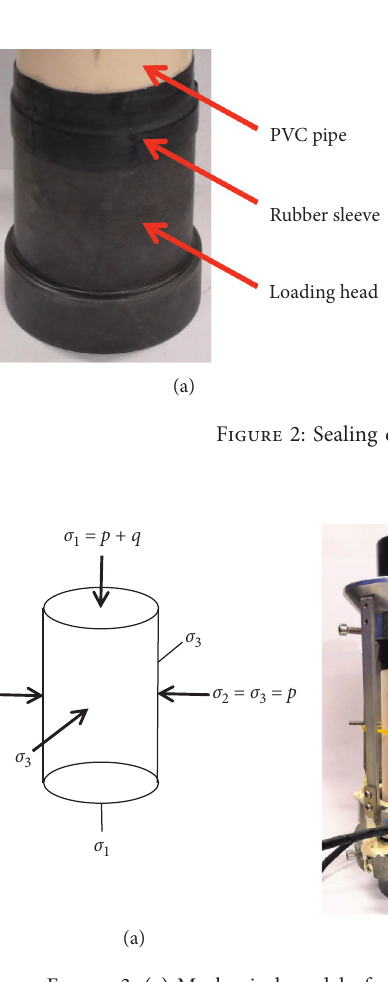
Figure 3: (a) Mechanical model of mortar. (b) Placement of extensometers.